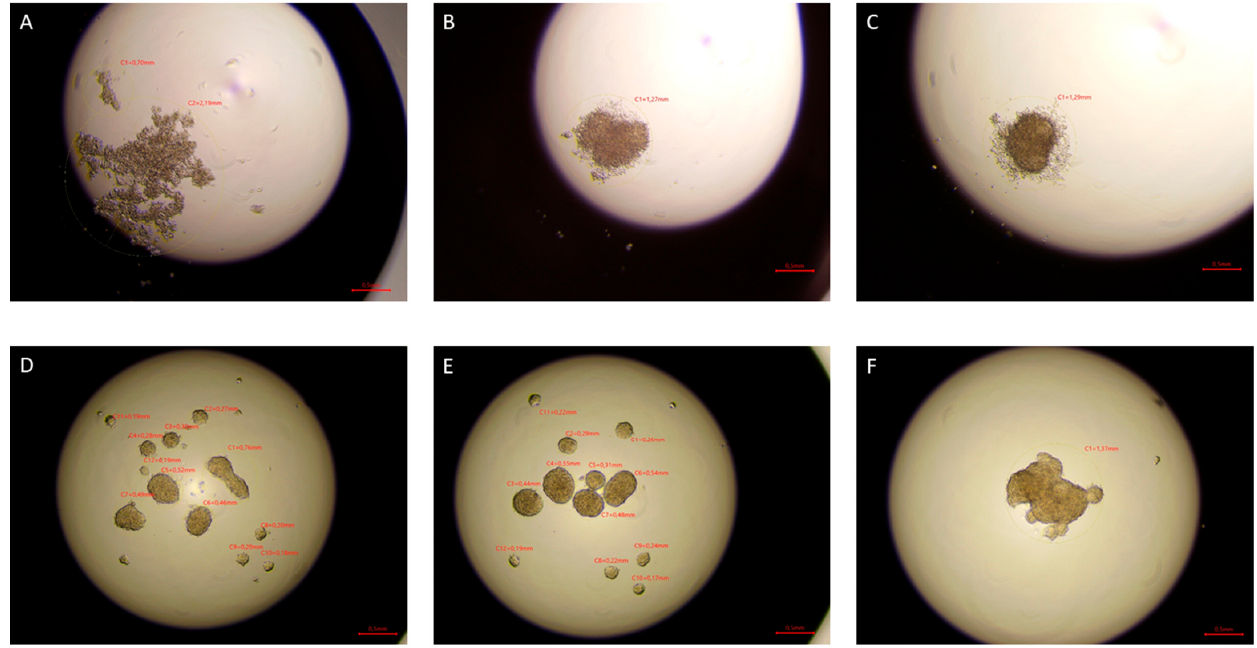
Figure 6. HEK293 cells in hanging drop culture. ( A – C ) show HEK293 cells from the control group 24, 48, and 72 h from the start of the culture, respectively. ( D – F ) show HEK293 cells exposed to 4.5 mT, 50 Hz EMF 24, 48, and 72 h from cultivation, respectively. Pictures taken with the Delta-Optical IB-100 microscope, 4× magnification.